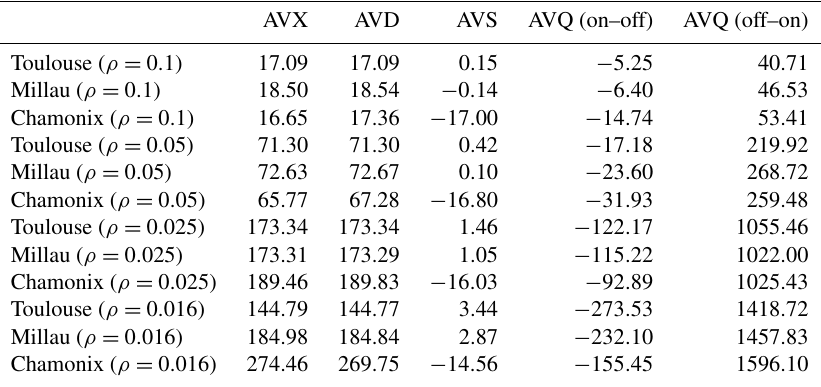
Table 8. Bias (in ppb) of several averaging biases before any bias correction schemes are applied on the three scenes for four reflectivity values. AVX AVD AVS AVQ (on–off) Toulouse ( ρ = 0 .